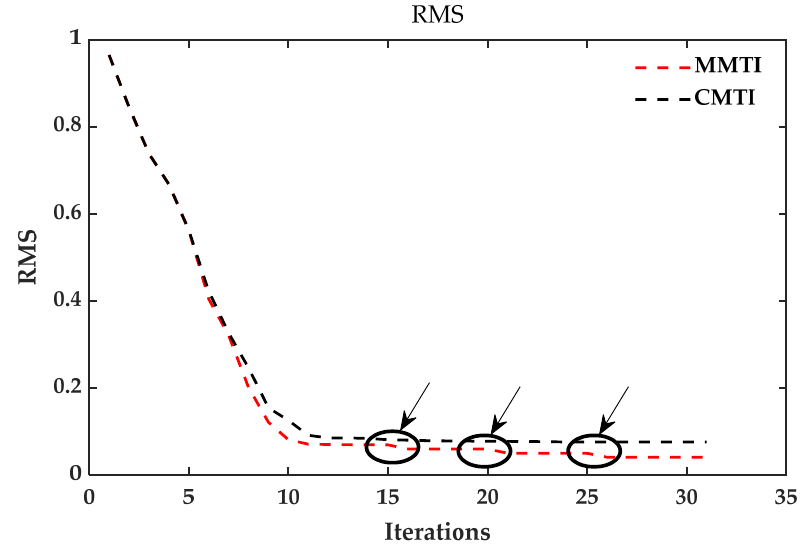
Figure 11. Comparison of RMS data fitting error between MMTI and CMTI.